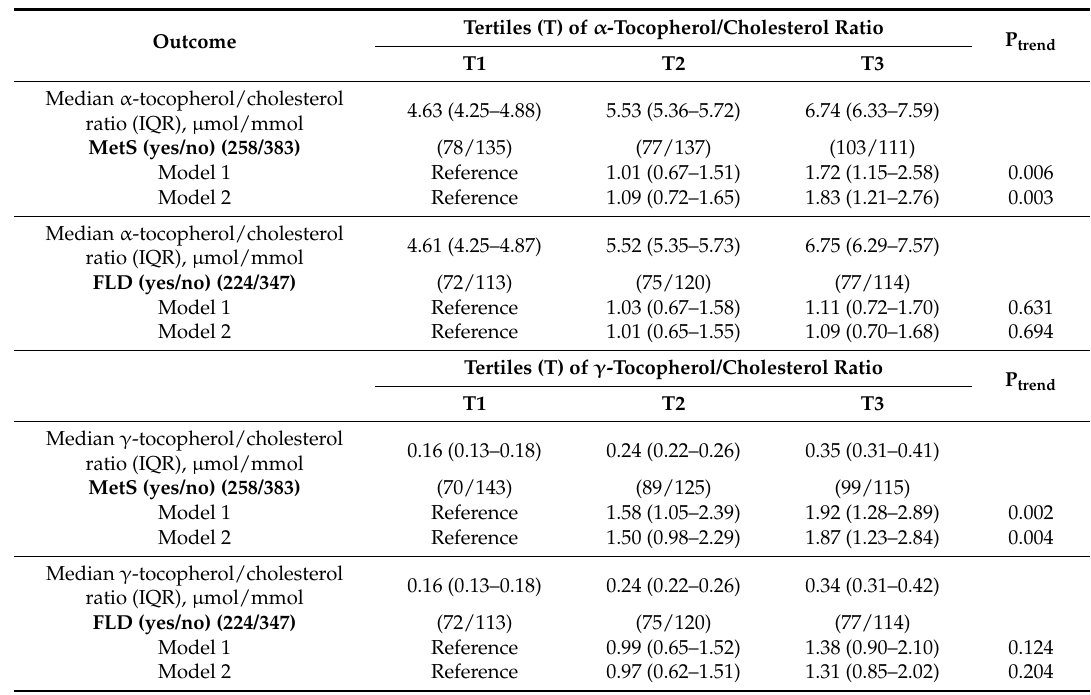
Table 5. Odds Ratio and 95% Confidence Interval for the association of α - and γ -tocopherol/cholesterol ratio with metabolic syndrome (MetS) and fatty liver disease